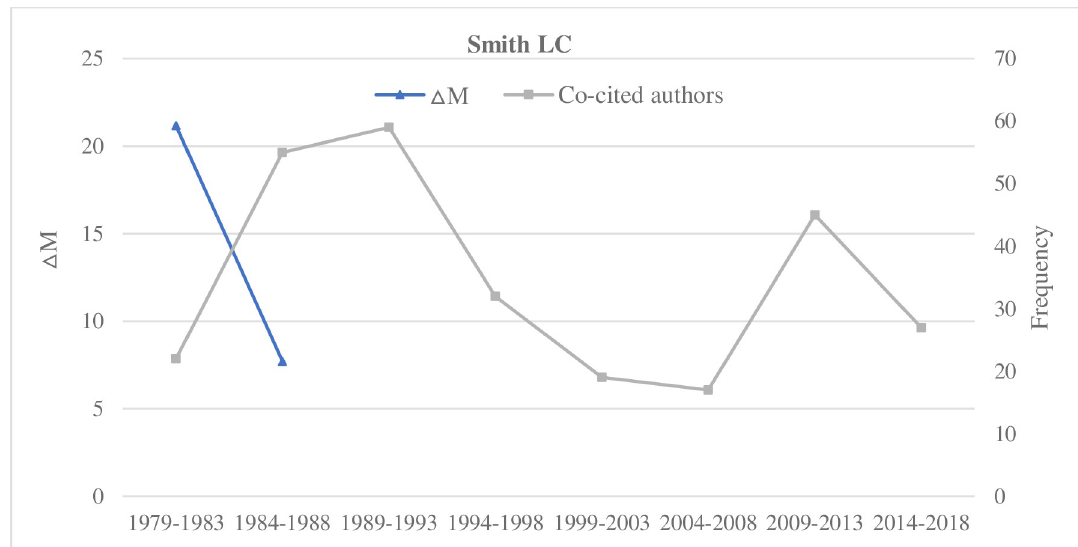
Fig 7. A decreasing Δ M trend and two peaks of co-cited author counts of Smith L.